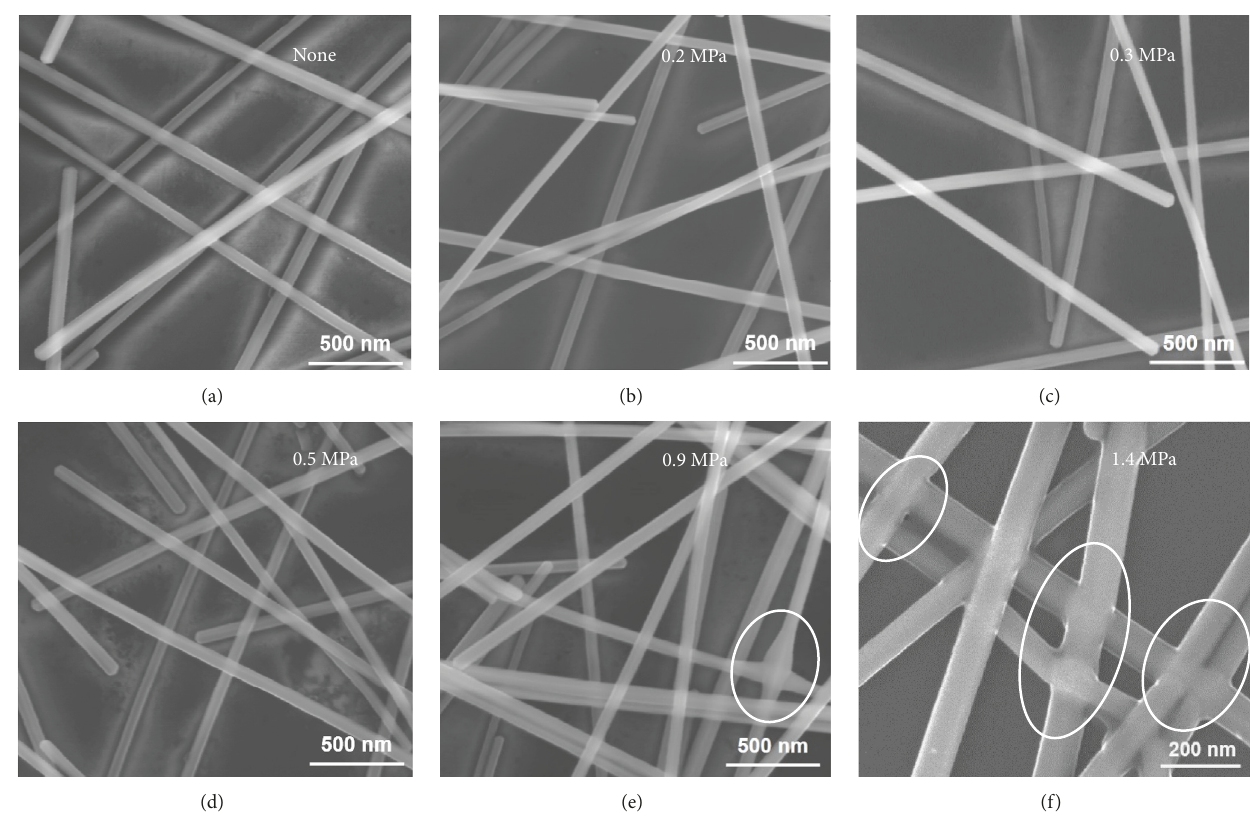
Figure 3: (a)-(f) SEM images of Ag NWs networks without (a) and at 0.2 (b), 0.3 (c), 0.5 (d), 0.9 (e), and 1.4 MPa (f) hot-pressing treatments at 100 ∘ C for